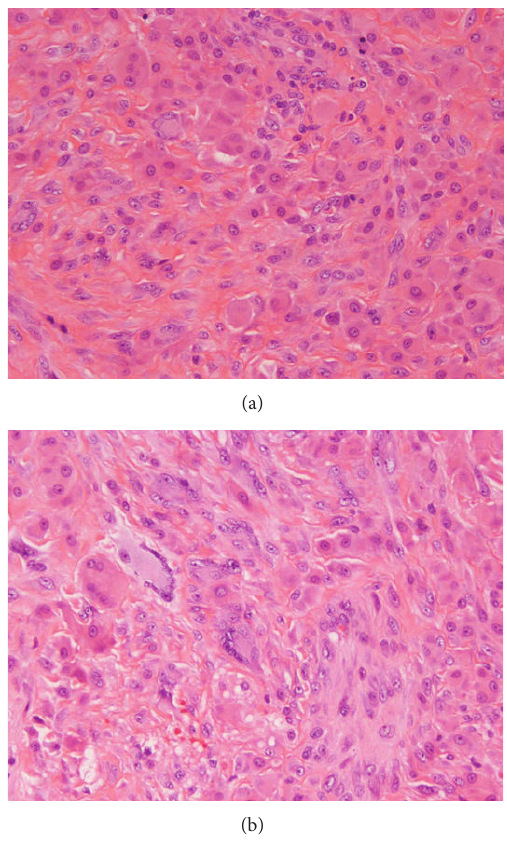
Figure 4: Histiocytic infiltration with multinucleated giant